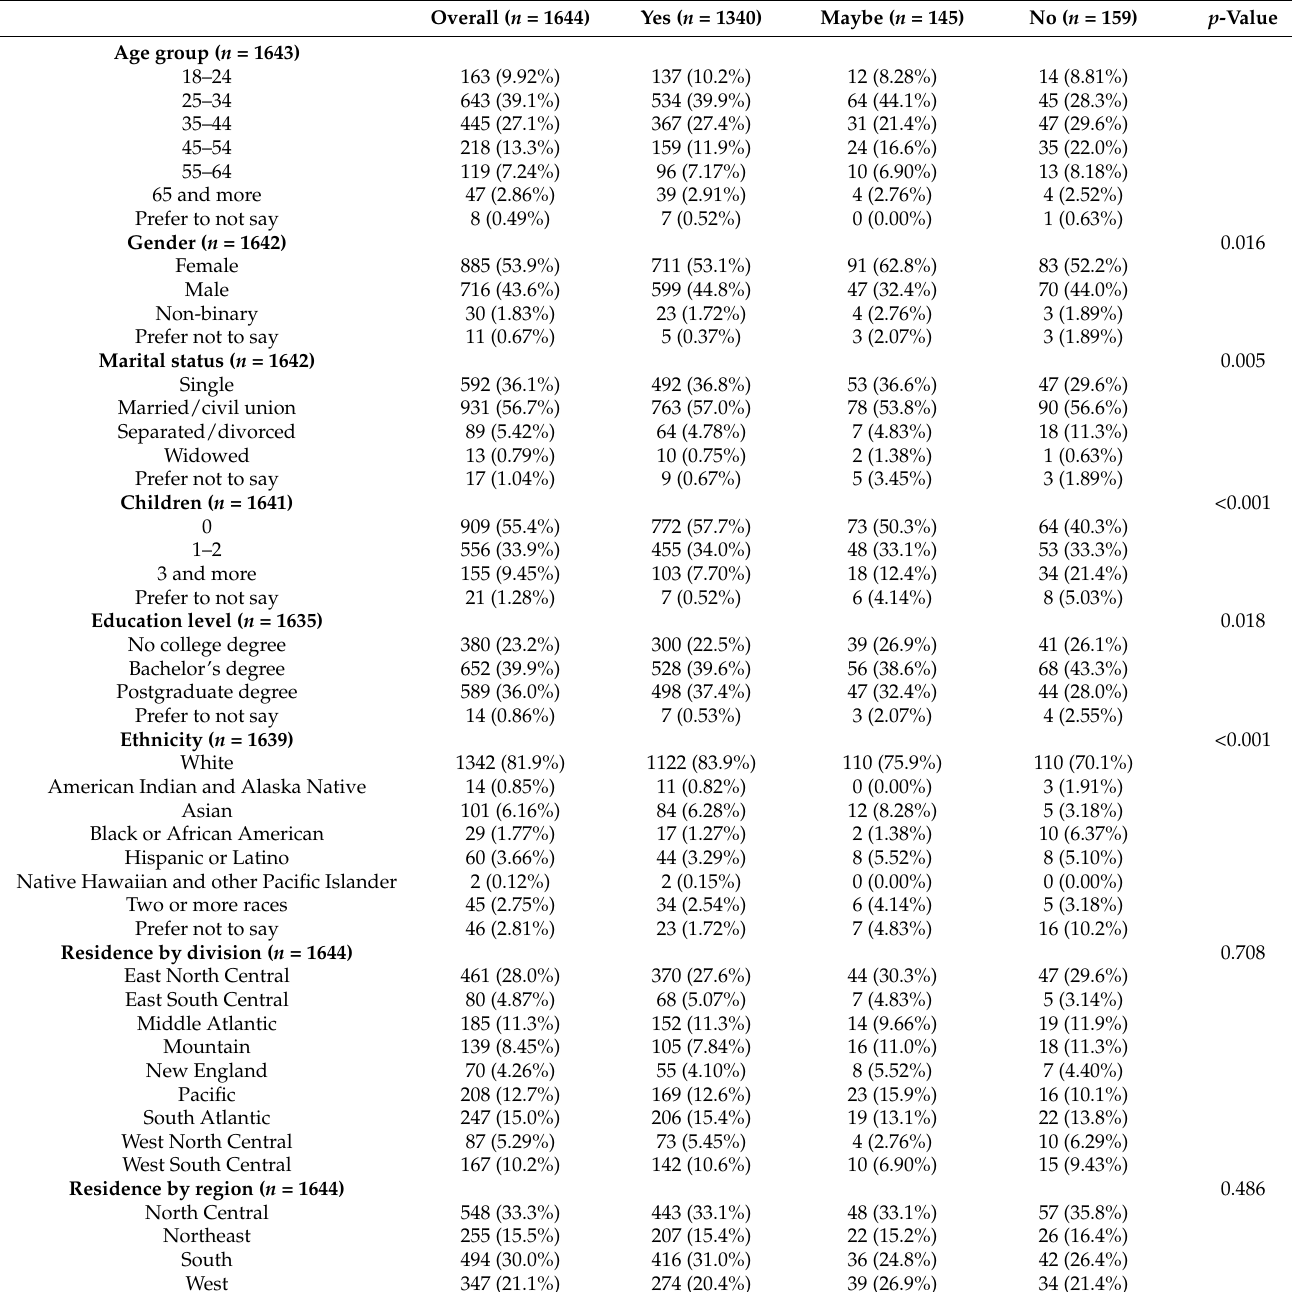
Table 2. Socio-demographic characteristics of the participants in the survey.